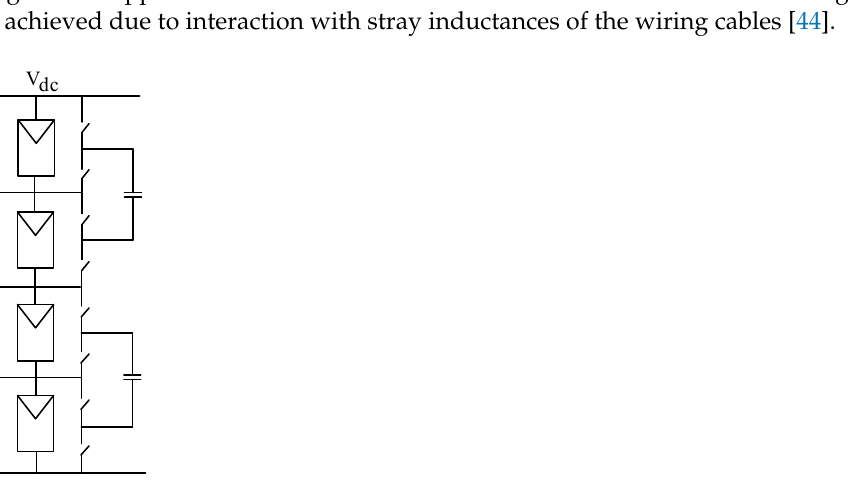
Figure 20. PV string with switched capacitor equalization scheme [41].